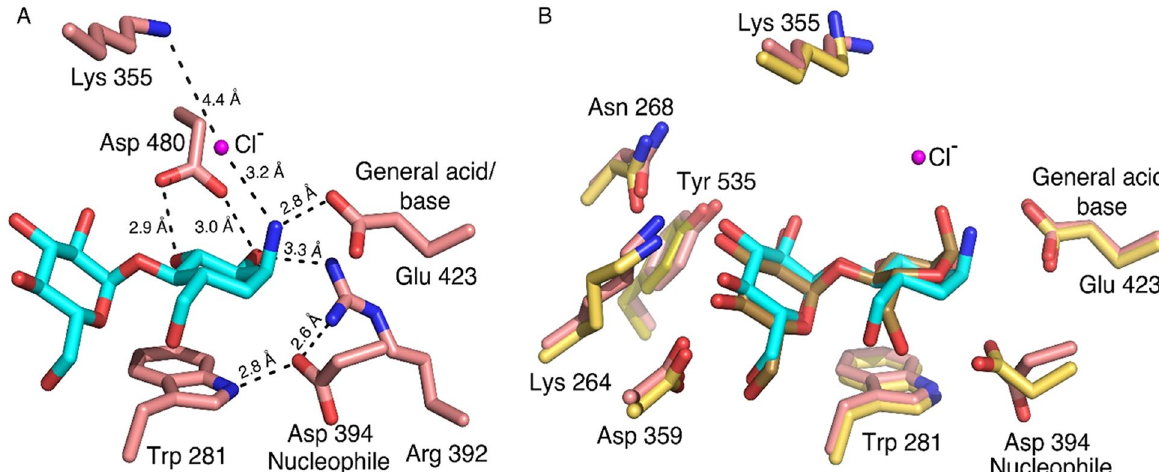
Figure 5. ( A ) The interactions formed in − 1 subsite of Sco GlgE1-V279S with 7 . ( B ) Superimposed active sites of Sco GlgE1-V279S/ 7 and Sco GlgE1/Maltose structures (yellow carbon